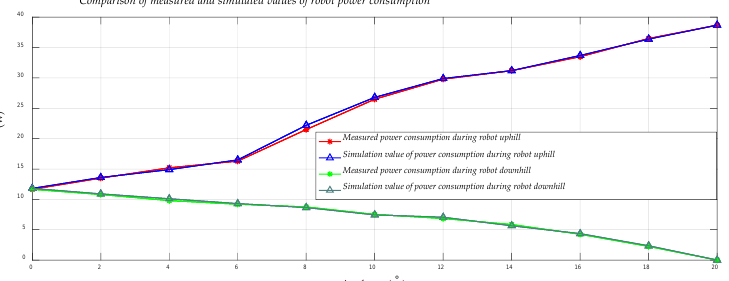
Figure 7. Comparison between the measured value and the theoretical value when the power consumption is stable during the robot’s uphill and downhill.